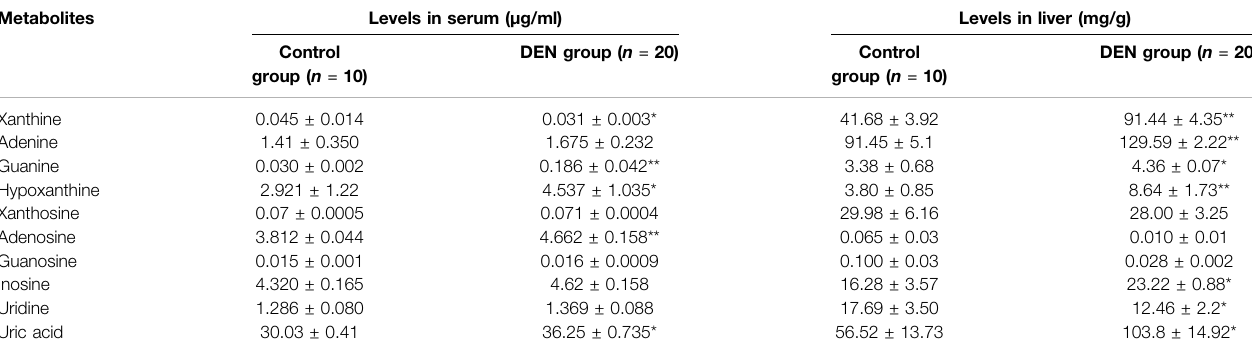
TABLE 1 | Absolute quantitation of purine metabolites in serum and liver of rats (mean ± S.E.M). Metabolites Levels in serum ( μ g/ml)